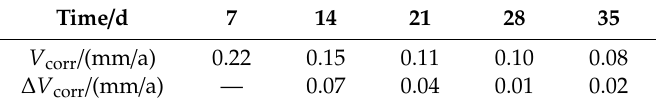
Table 3. Corrosion rate of Q235B steel in desulfurization solution.